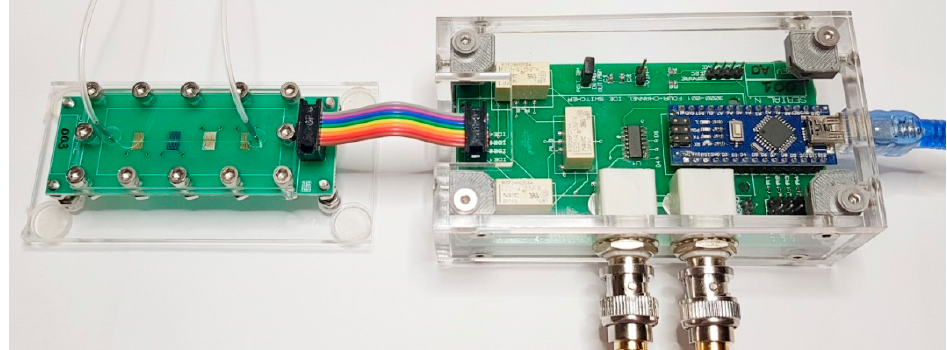
Figure 4. Final device for rapid impedance measurements: impedimetric e-tongue in a single